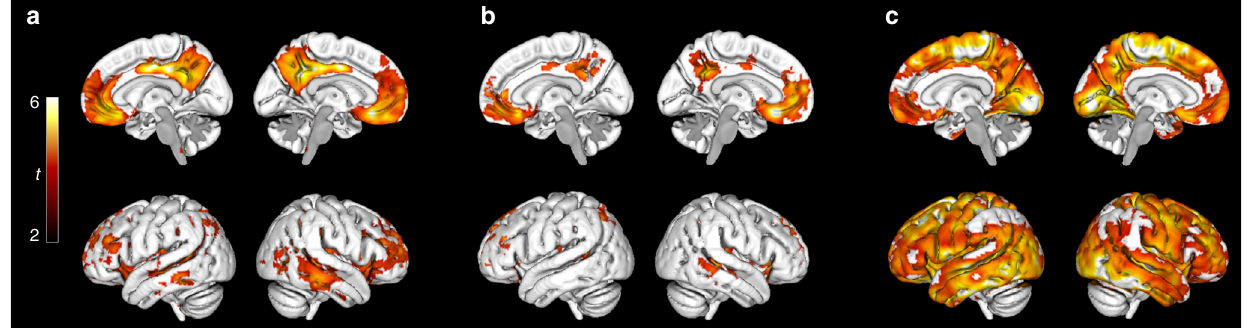
Fig. 1 Regions of A β accumulation from longitudinal voxelwise analyses in ADNI. a shows the regions where A β fi brils start to accumulate by comparing the annual fl orbetapir SUVR rate during 2 years between early stage A β accumulators (CSF+/PET − , n = 59) and non-accumulators (CSF − /PET − , n = 218). The lateral and medial projections in a show that the most signi fi cantly increased accumulation rate among the early A β accumulators was located in the posterior cingulate cortex, the precuneus, and the medial orbitofrontal cortex. A PET-data-derived ROI of these early-accumulating A β regions is available at http://bio fi nder.se b con fi rms the regions in a without biases from a speci fi c CSF A β 42 cut-off. Here, we performed voxelwise correlations between annual fl orbetapir SUVR rates and CSF A β 42 levels in A β PET negative individuals ( n = 277). To contrast the early stage A β regions, c shows the regions with signi fi cantly increased annual SUVR rate in late stage A β accumulators (CSF+/PET+, n = 191) compared with non-accumulators (CSF − /PET − ). A widespread pattern of A β accumulation is seen in these non-demented CSF+/PET+ subjects. Voxelwise two-sample t -tests were used and all analyses